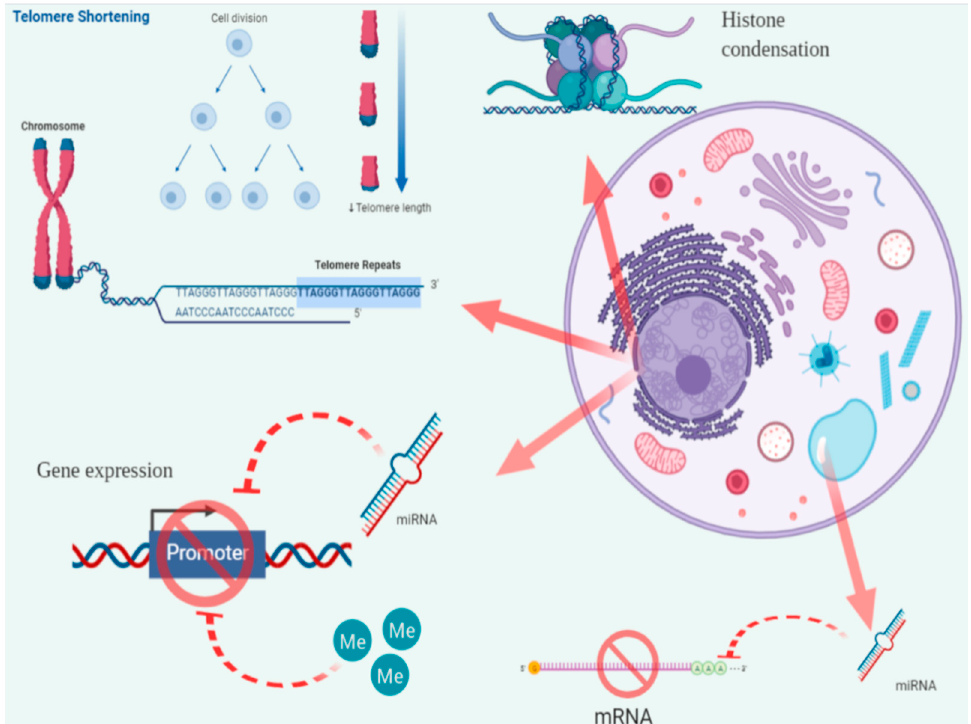
Figure 1. Graphic representation of the underlying pathophysiology of NMSC formation. Carcinogenic mechanisms located in the nuclear apartment involve telomere shortening, histone condensation, inactivation of tumor-suppressor promoters by miRNA and/or methylation. Carcinogenic mechanisms located in the cytosol involve inactivation of mRNAs by miRNAs. Me: methylation.